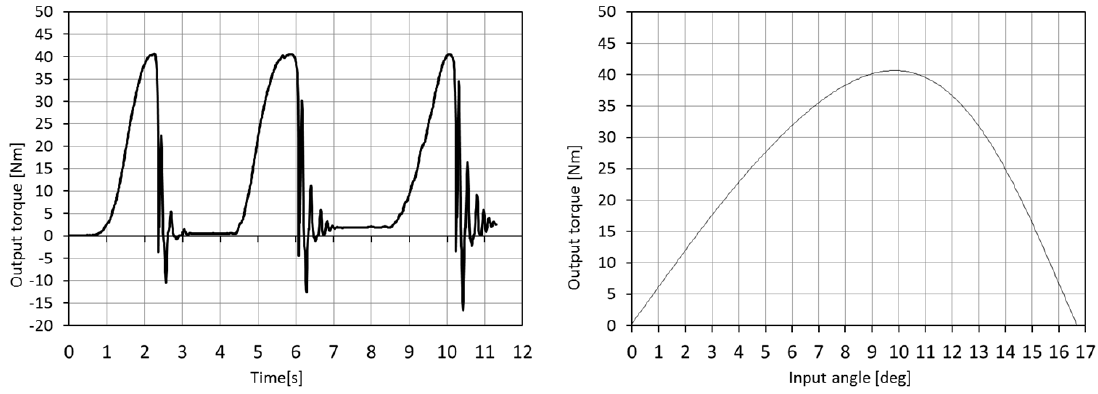
Figure 12. Torque ripple and the torsional stiffness at 20 °C.